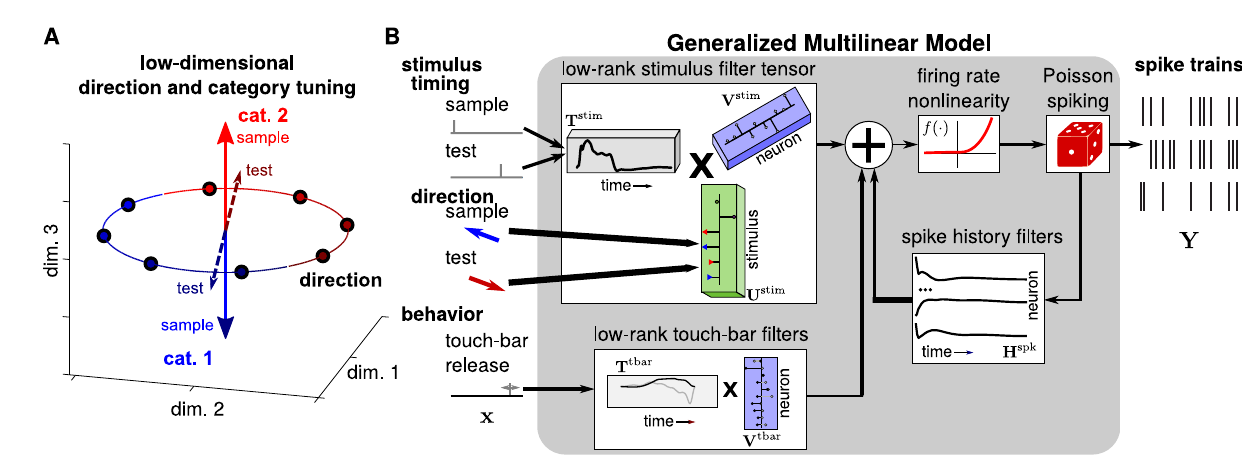
Fig. 3 | The generalized multilinear model for dimensionality reduction of neuralpopulations.A We hypothesized thatthe differentstimulusdirectionsand categories — including whether it is the sample or test stimulus — could be modeled as vectors as a function of time in a low-dimensional space where the dimension- ality is the number of factors. Here, we constrain the direction tuning, but not category, to be the same over the sample and test stimuli. Thus, dimensionality reduction in our framework can take into account shared temporal dynamics and stimulus tuning information across the two stimulus presentations, possibly re fl ecting similar bottom-up input. Individual neurons ’ stimulus tuning is a linear projectionofthelow-dimensionalspace. B DiagramoftheGMLM.Incomingstimuli arefactorizedintotemporaleventsandstimulusweightsthatencodedirectionand